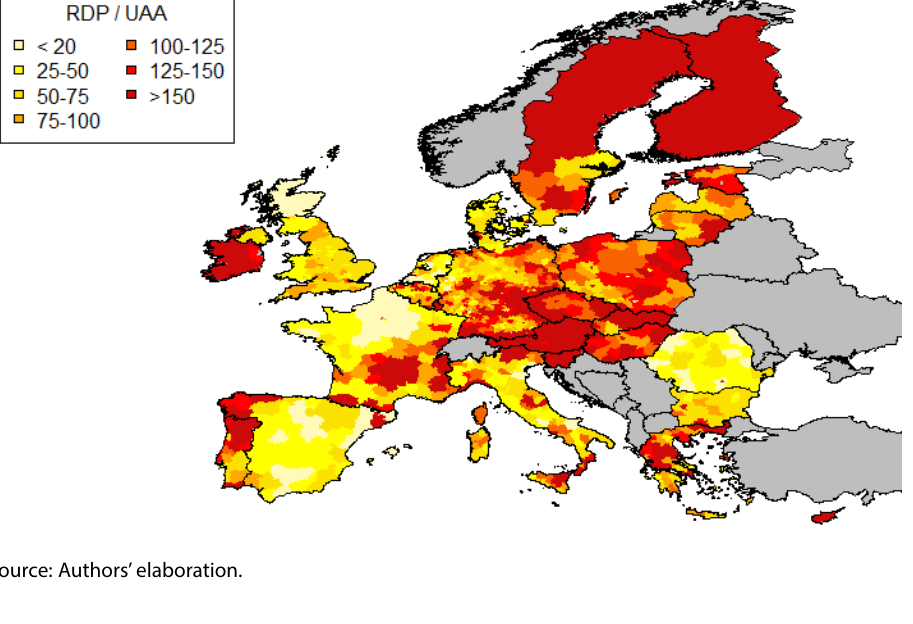
Figure 4. 2007-2009 RDP expenditure per agricultural Annual Working Unit (€/AWU).